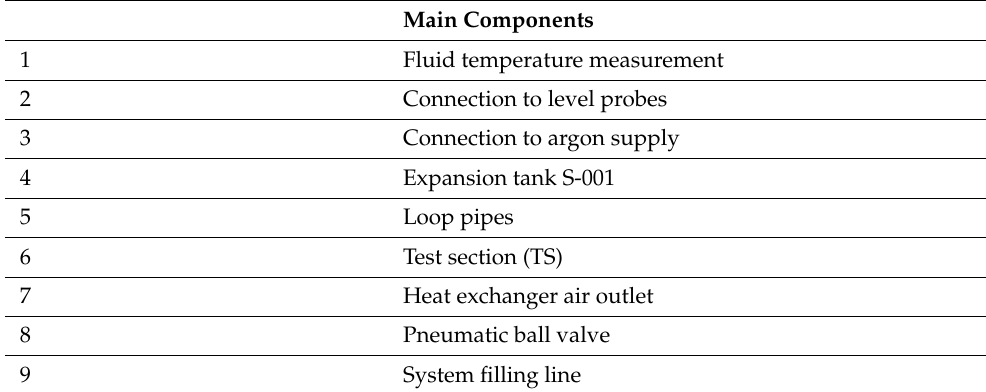
Table 1. Main components of the loop, as indicated in Figure